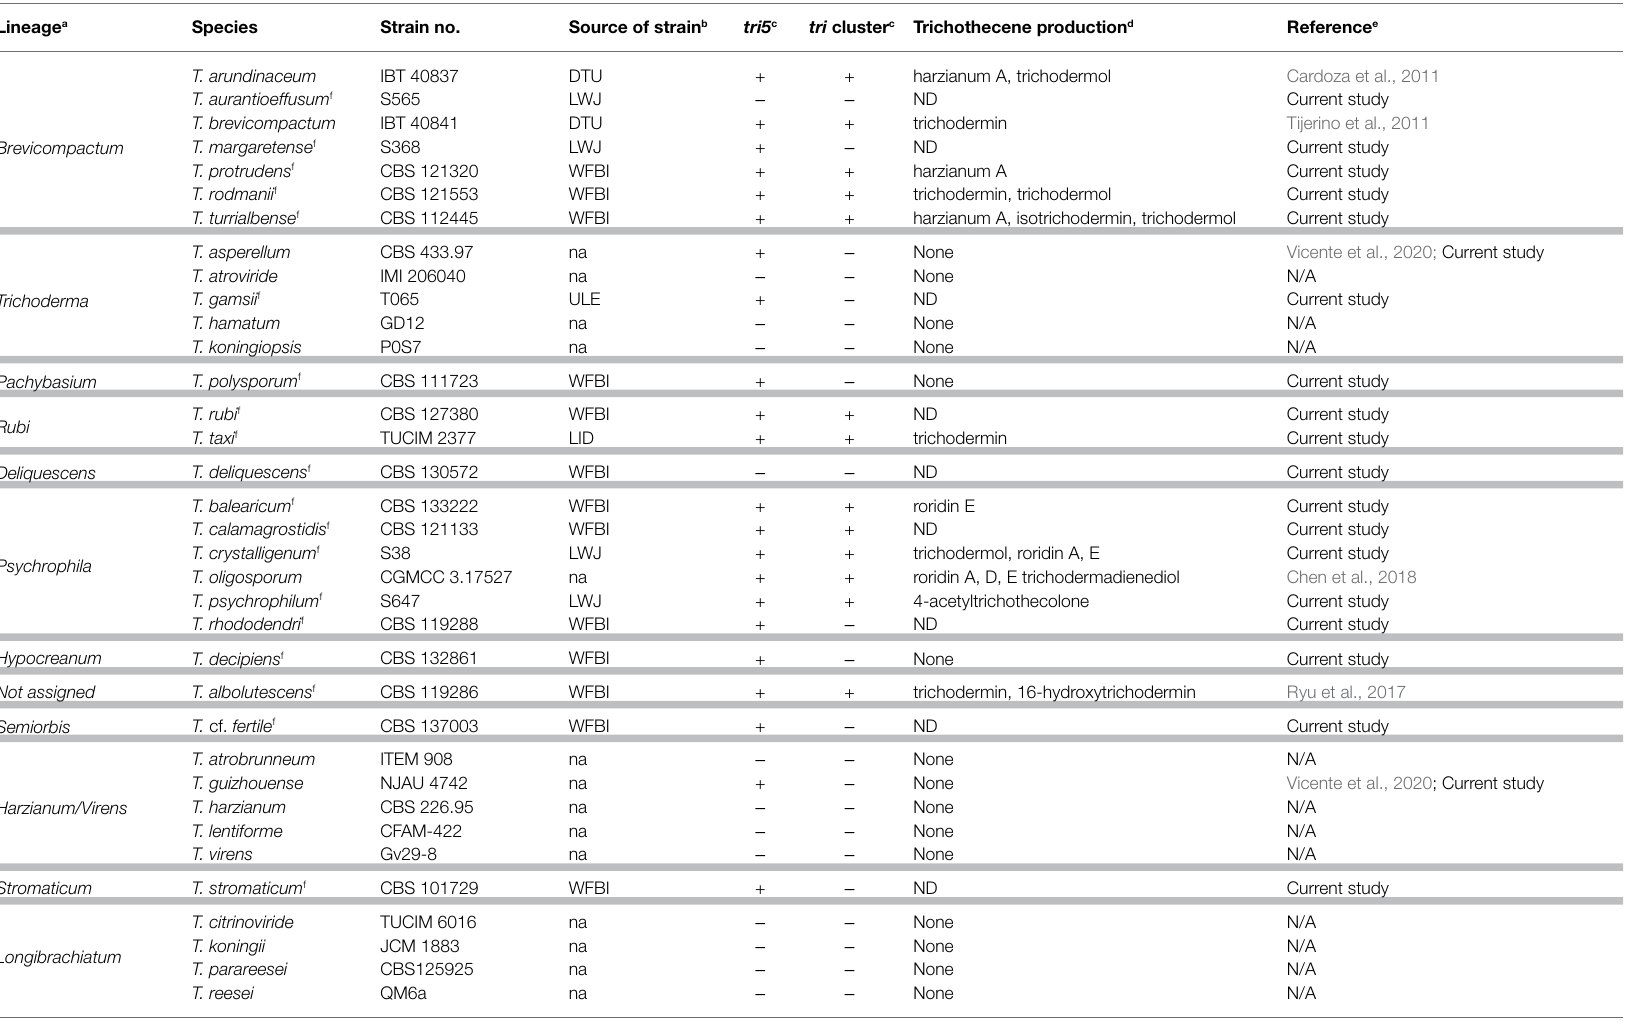
TABLE 1 | Trichoderma species and strains examined in the current study, and the occurrence of tri5 , the tri cluster, and trichothecene production in the species/strains. Lineage a Species Strain